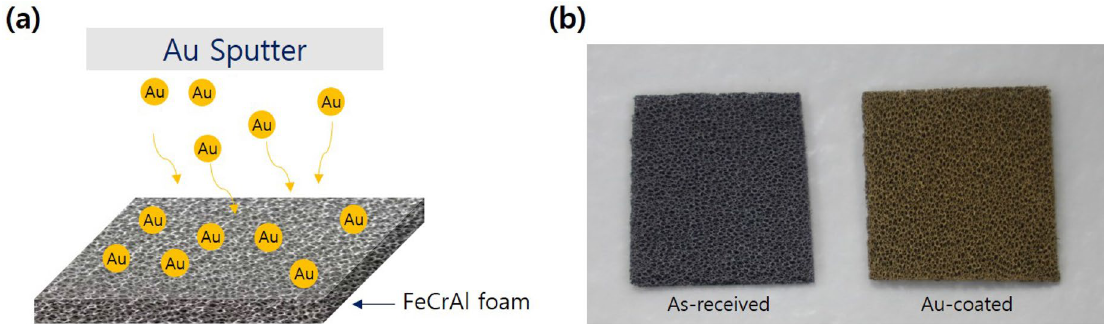
Figure 1. ( a ) Schematic view of Au sputtering on FeCrAl foam and ( b ) photographs of as-received and gold- coated FeCrAl foam